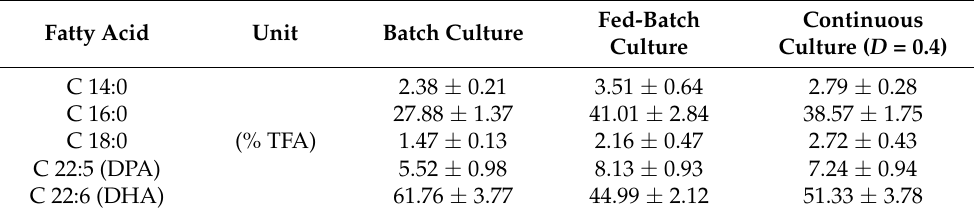
Table 6. Composition of fatty acids produced by Schizochytrium sp. microalgae in different cul- ture